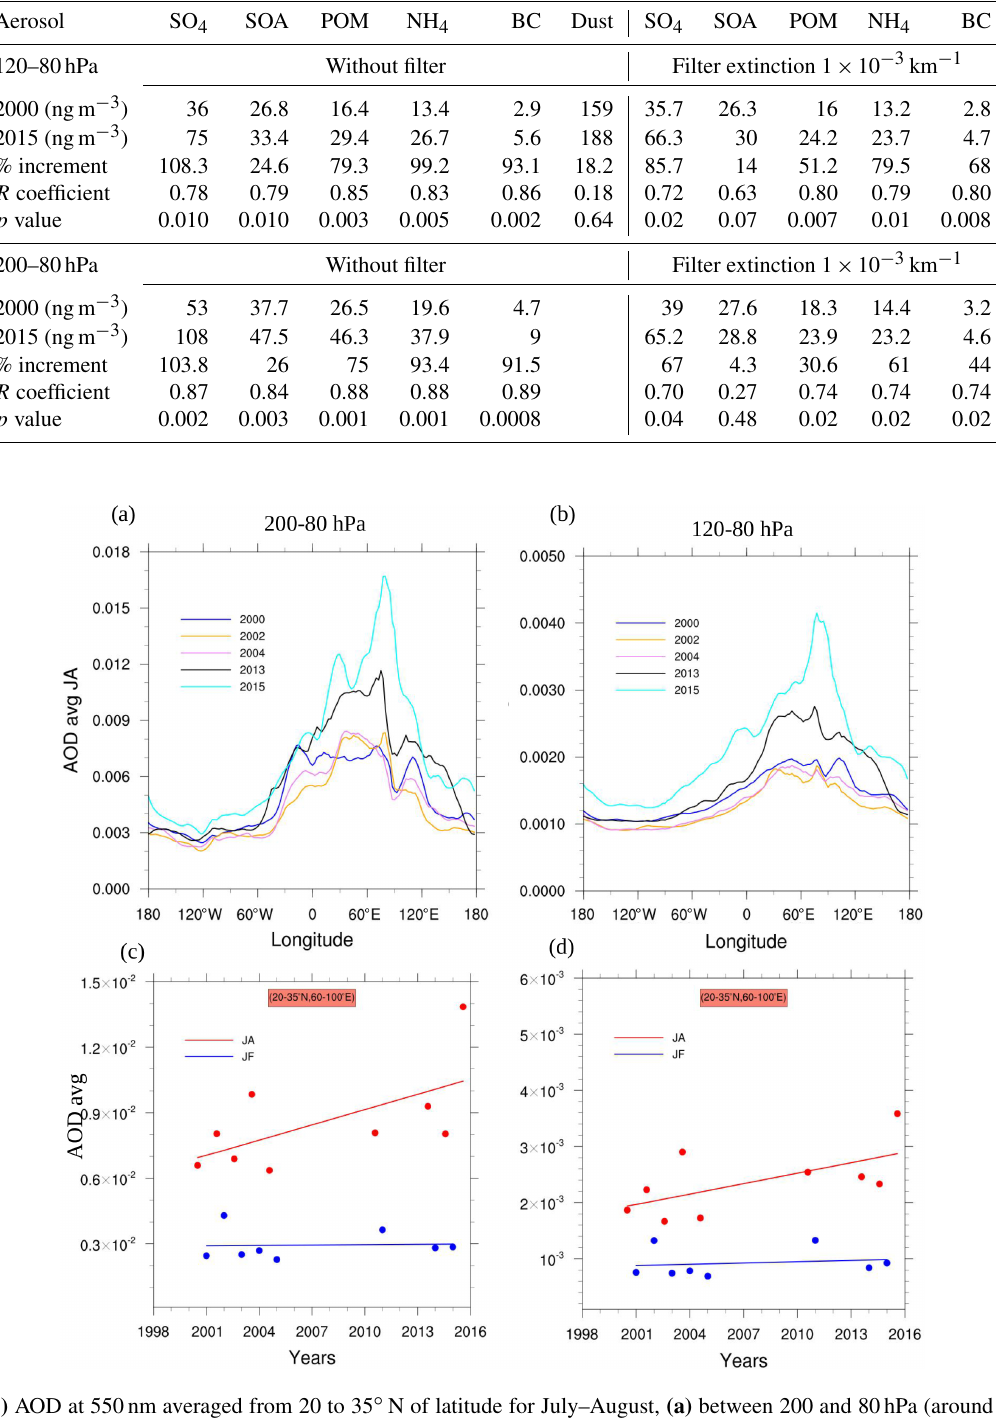
Figure 6. (a, b) AOD at 550nm averaged from 20 to 35 ◦ N of latitude for July–August, (a) between 200 and 80hPa (around 13 to 18km), and (b) between 120 and 80hPa (around 15.7 to 18km). Different colors represent the different selected years. (c, d) AOD trends for July– August (red) and January–February (blue) averaged between 20–35 ◦ N and 60–100 ◦ E, (c) between 200 and 80hPa and (d) between 120 and 80hPa. The plots show the trends excluding the years with volcanic eruptions impacting the UTLS.